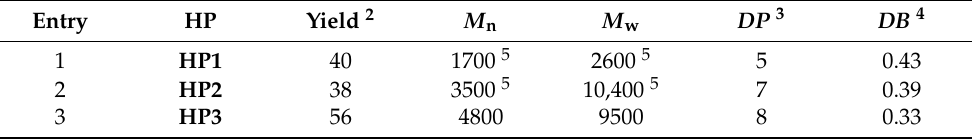
Table 1. Main characteristics of hyperbranched polymers HP1-3 1